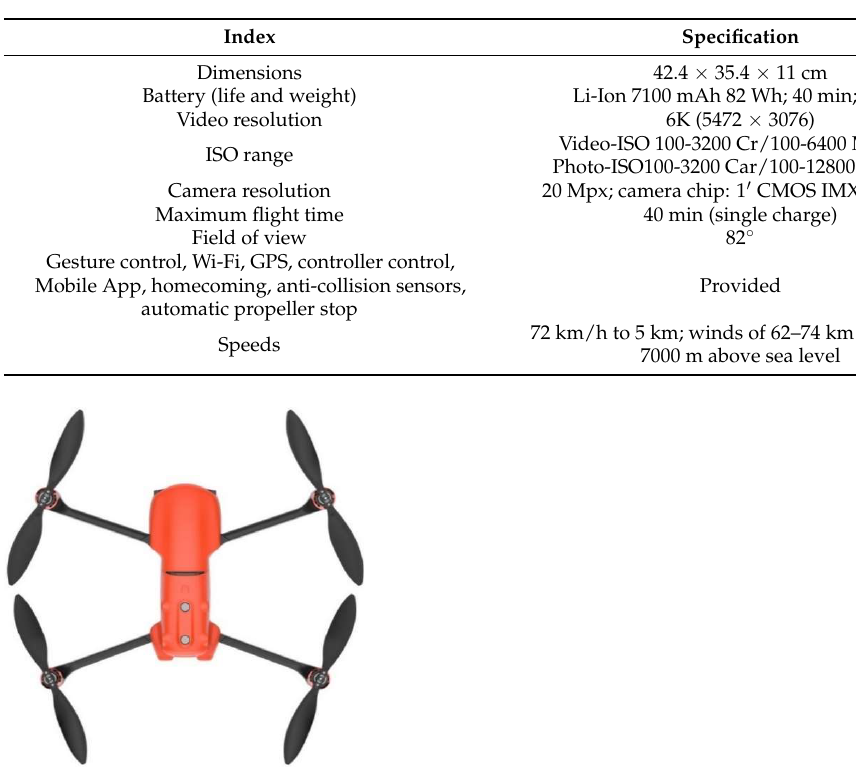
Table A1, Figures A1–A3. Table A1. Technical data of UAV used.